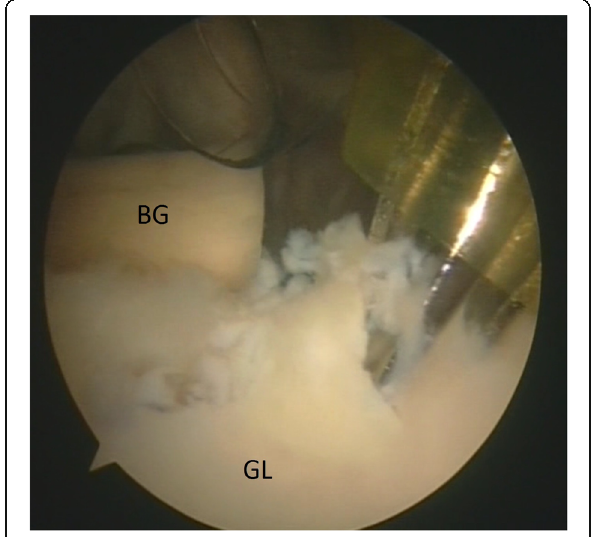
Fig. 6 Left shoulder, anterior on the top and posterior on the bottom, scope from posterior portal, drill from antero-superior portal. Drill hole at 10 o ’ clock position for the anchor (BG: bone graft, GL: